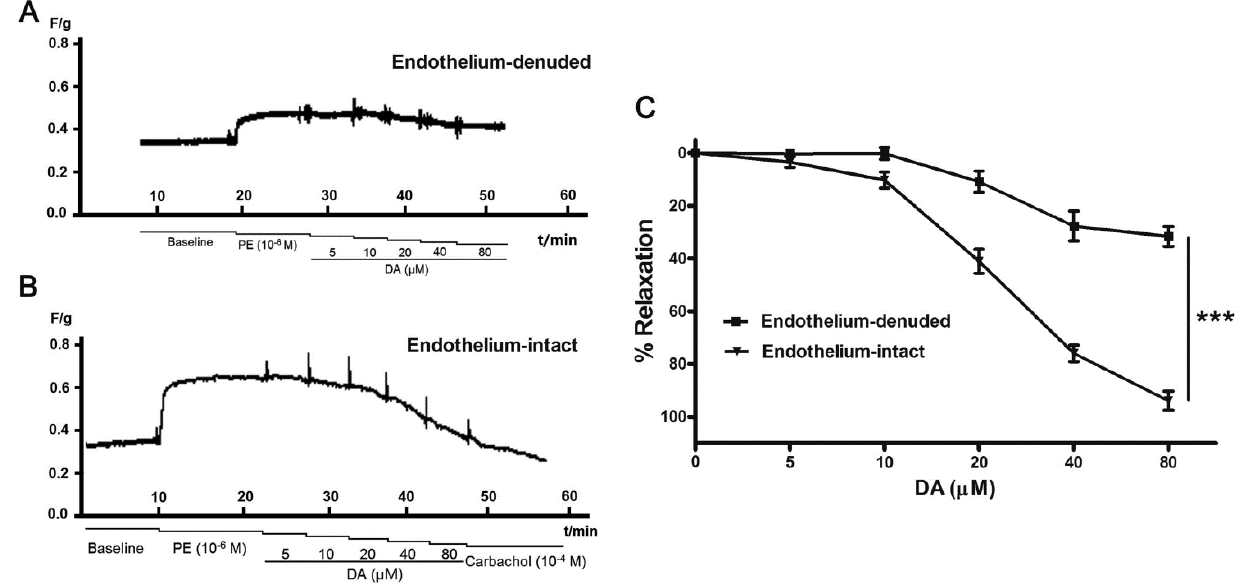
Figure 4. Effect of DA on endothelium-intact and endothelium-denuded rat pulmonary artery. Cumulative dosing of DA vasorelaxant effect on both endothelium-intact and endothelium-denuded rats pulmonary artery rings were detected ( A , B ). The results are represented as the means ± SEM ( n = 5) ( C ), *** p < 0.001 for subdued effect of endothelium-denuded versus endothelium-intact